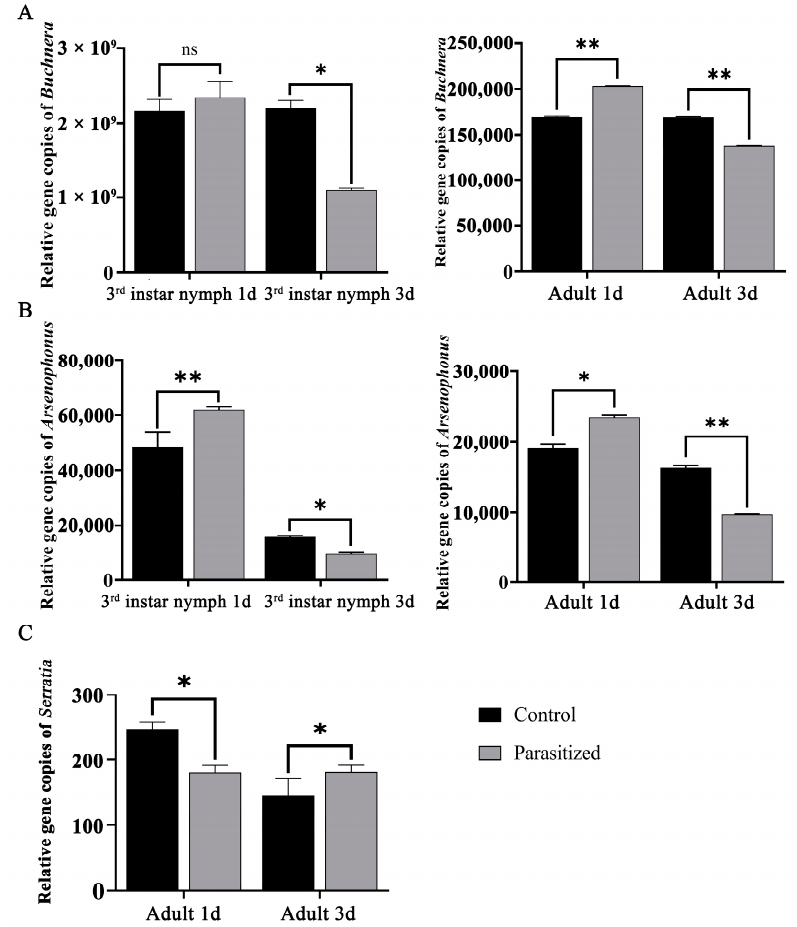
Figure 6. ( A ) Copy numbers of Buchnera ( A ), Arsenophonus ( B ), and Serratia ( C ), 16S rDNA gene in the ovaries of parasitized and non-parasitized cotton aphids. We did not perform RT-qPCR for nymph stage Serratia due to its low relative abundance. Asterisks define the p -values as follow: * < 0.05 and ** < 0.01, ns indicates that no significant difference in copy